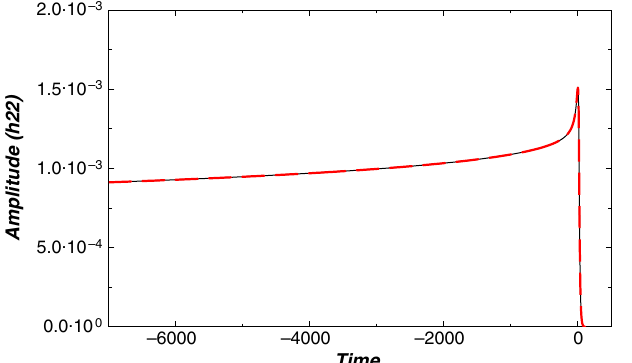
FIG. 1. The full waveform amplitude emitted by the inspiral, plunge, and ringdown of the particle into the central Kerr black hole calculated both with the hyperboloidal code (black), and the Cauchy code (dashed red line). The merger time ( (cid:3) ¼ 0 ) is defined rather arbitrarily by the time of maximum amplitude. The codes agree so well that the two curves are on top of each other (see Fig. 3 for the difference).